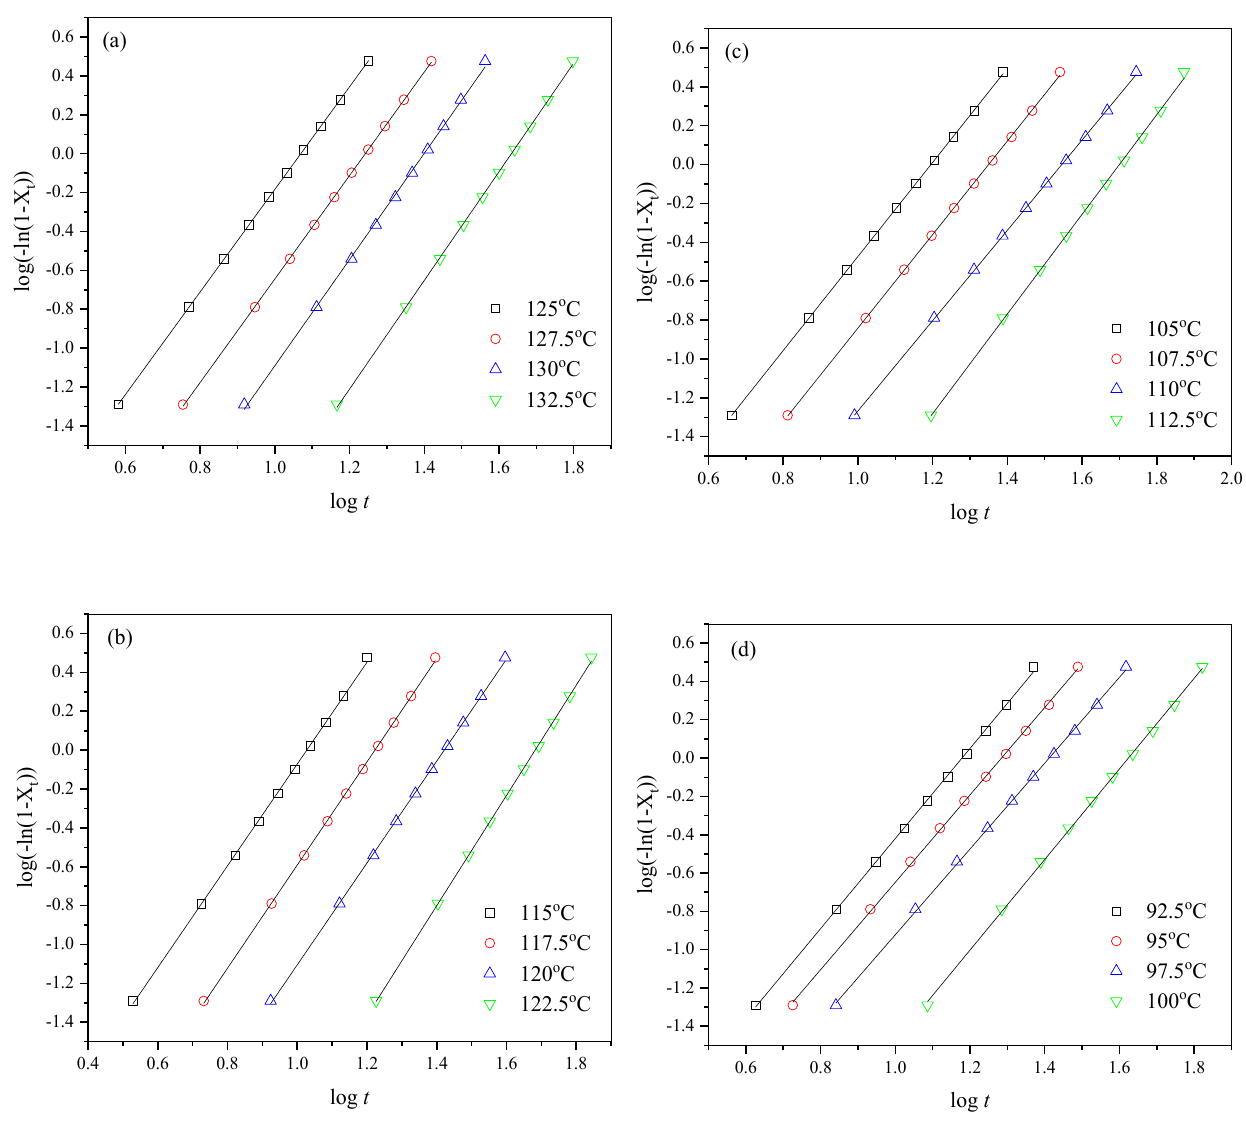
Figure 6. The related Avrami plots for ( a ) PHF, ( b ) PHFSe10, ( c ) PHFSe20, and ( d ) PHFSe30.